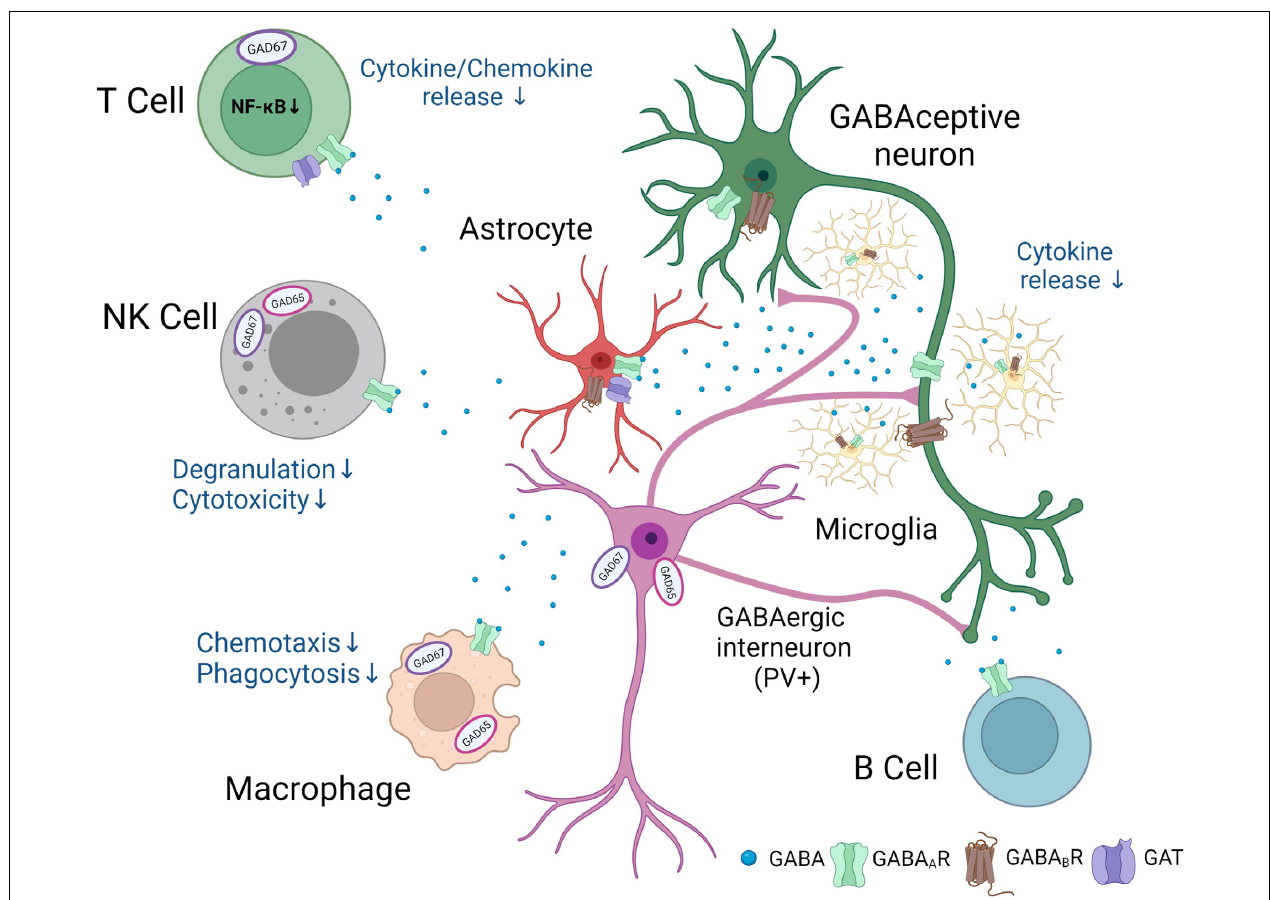
FIGURE 1 | Putative involvement of GABAergic signaling in neuro-immunological crosstalk after stroke. Following stroke, neurons, glial, and immune cells synthesize and release GABA. In addition, GABA A and GABA B receptors and specific GABA transporters are found in a number of immune and glial cells. GABA exerts anti-inflammatory effects and changes in the function of GABAceptive neurons indicated in the figure. The figure was created with